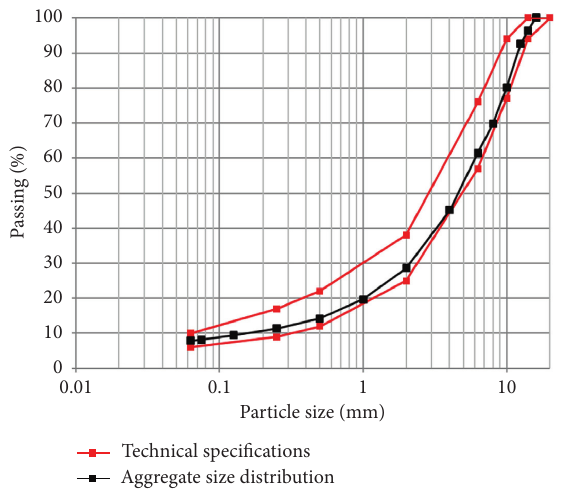
Figure 3: Aggregate size distribution and limits imposed by the technical